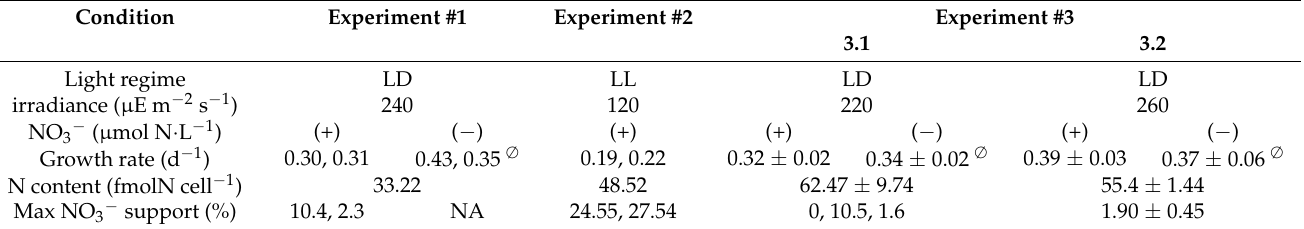
Table 1. Summary of the experimental conditions tested, and data acquired, in the three series of experiments. LD, Light:Dark. LL, Light:Light (i.e., continuous light). (+) and ( − ) indicate that cultures were grown with or without NO 3 − . Max NO 3 − support, maximum percentage of the N incorporated in the biomass possibly supported by NO 3 − uptake. The symbol ∅ indicates that averages measured in the NO 3 − -rich and NO 3 − -free cultures (in a given experiment) are not statistically significant at the 5%